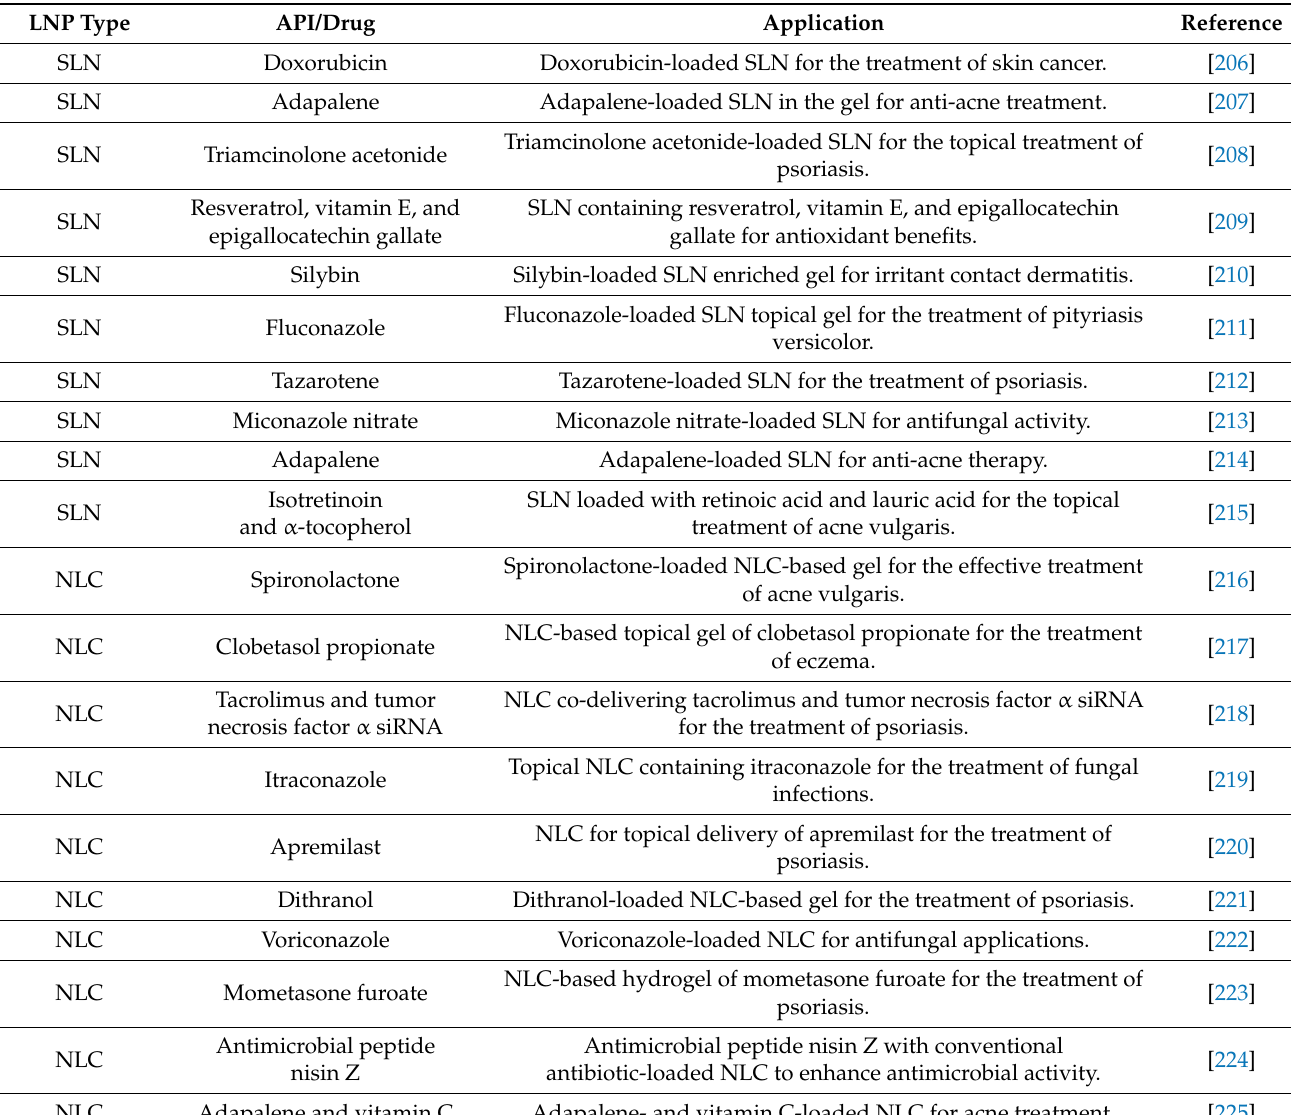
Table 6. Application of SLN and NLC DDS for the treatment of skin